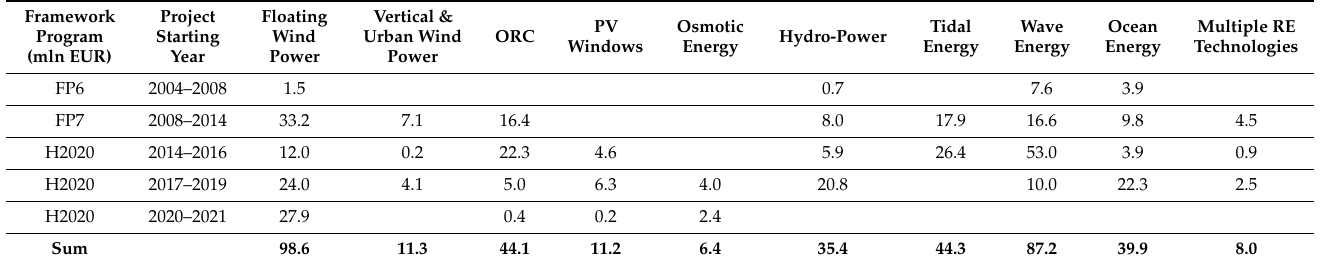
Table 10. EU funding within the FP6, FP7 and H2020 for selected renewable energy technologies (values in mln EUR) (based on [55]).